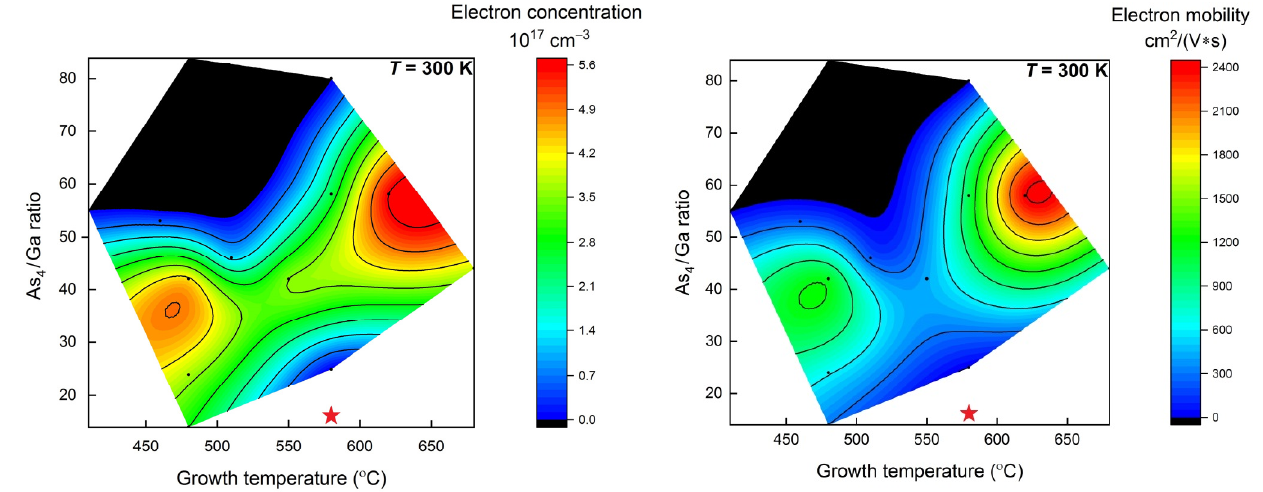
Figure 4. Electron concentration and mobility vs. growth temperature and As 4 /Ga ratio (black dots are experimental measurements, values of n and μ are conventionally considered zero for non-measurable samples with too low conductivity, out-of-order sample #87 with hole conductivity is marked by asterisk outside the interpolation area).